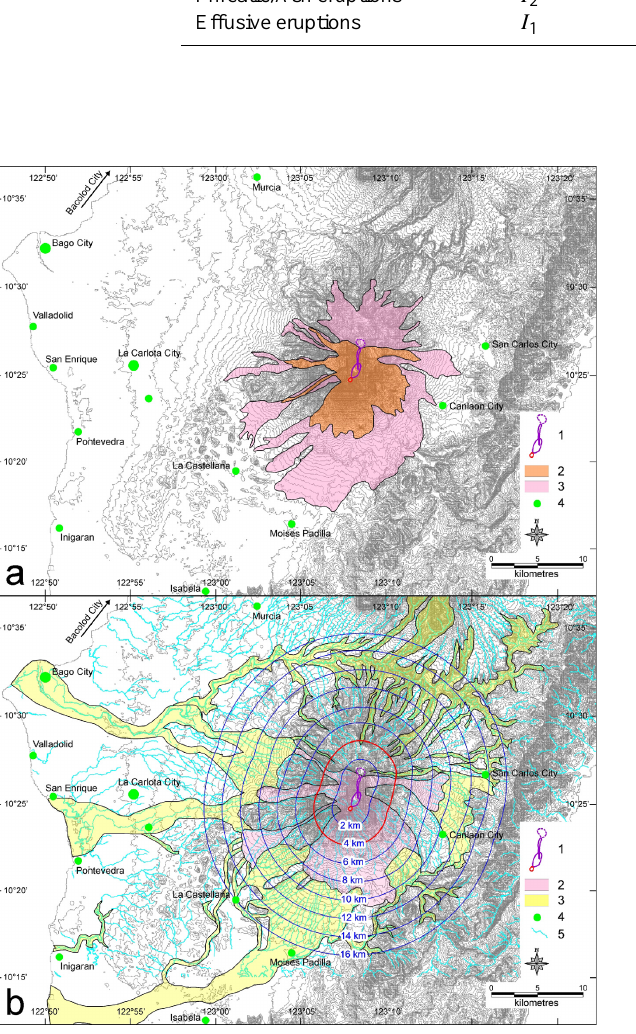
Fig. 7. Volcanic hazard map of Kanlaon (modified from http:// www.phivolcs.dost.gov.ph). (a) Lava hazard map: 1 – active sum- mit vents; 2 – area prone to high hazard of lava invasion; 3 – area prone to slight hazard of lava invasion; 4 – main towns and villages. (b) Pyroclastic and lahar hazard map: 1 – active summit vents; 2 – areas highly prone to pyroclastic flows; 3 – areas highly prone to lahars; 4 – main towns and villages; 5 – drainage system. The elliptical blue lines show areas progressively further away from the summit active vent. The area within 4km from the summit vents, highlighted in red, indicates the area of maximum volcanic